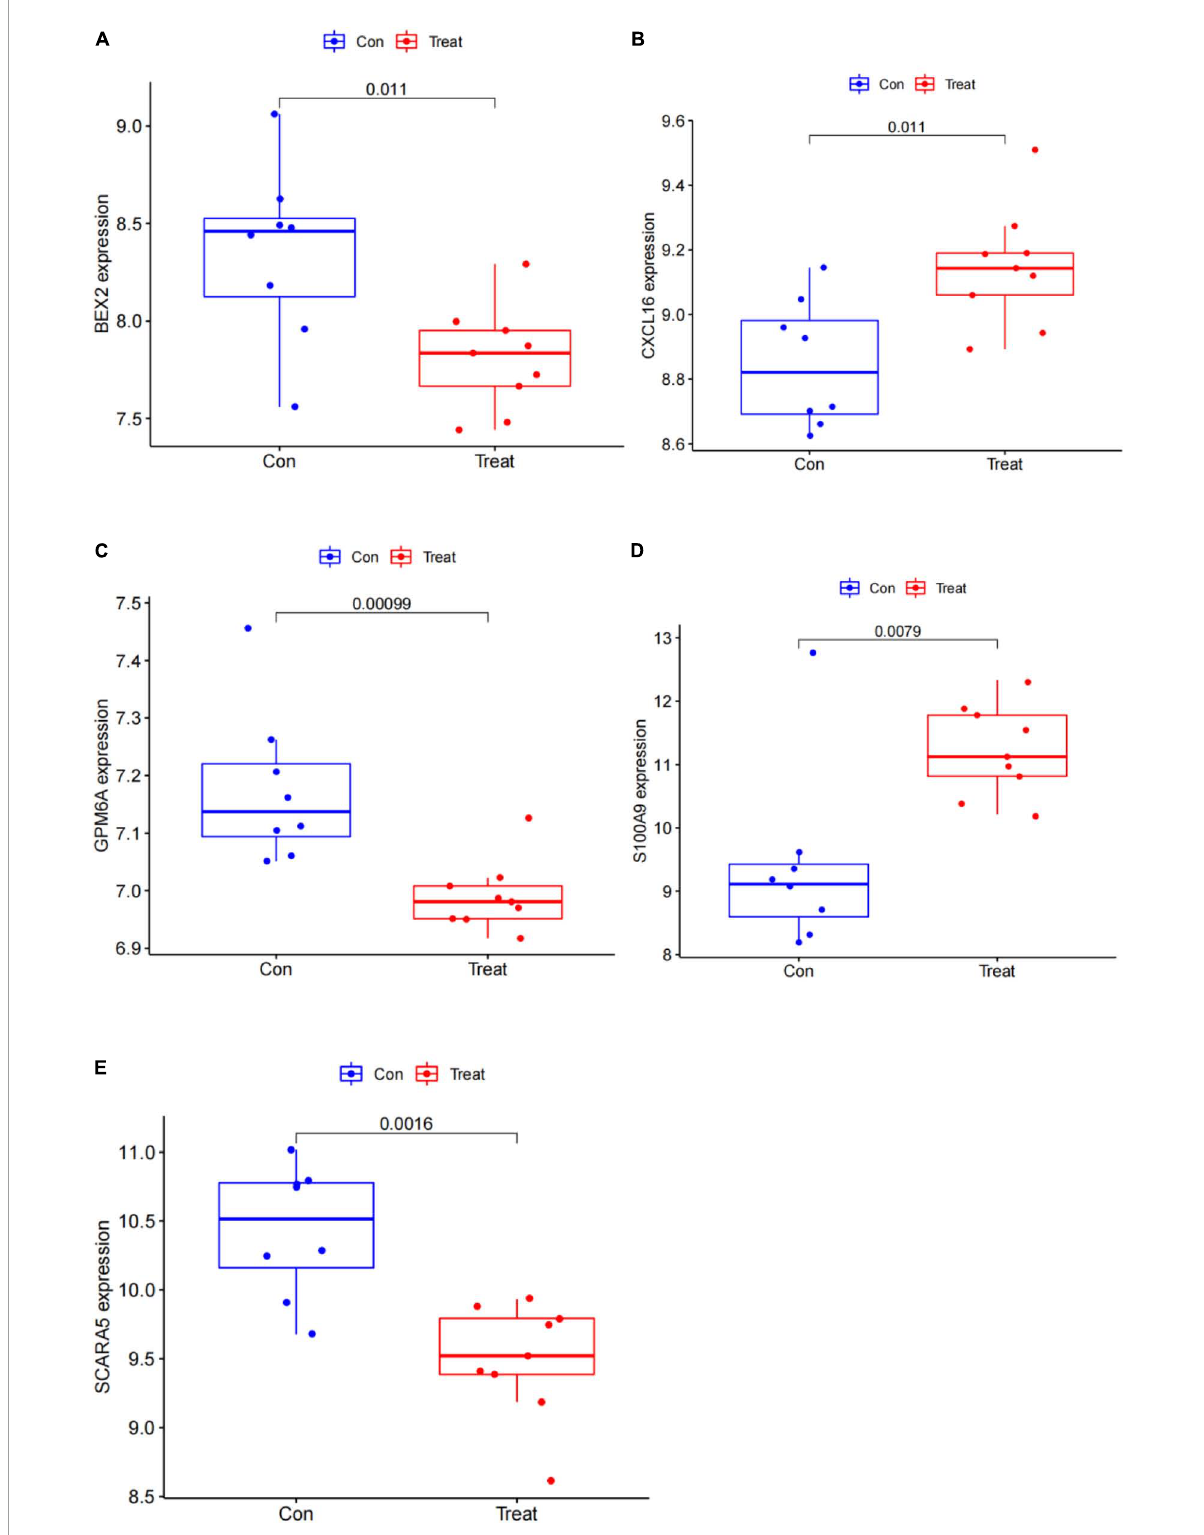
FIGURE6 Gene expression of five markers is visualized using a box plot in the test set. (A) Box plot of BEX2 expression in the test set. (B) Box plot of CXCL16 expression in the test set. (C) Box plot of GPM6A expression in the test set. (D) Box plot of S100A9 expression in the test set. (E) Box plot of SCARA5 expression in the test